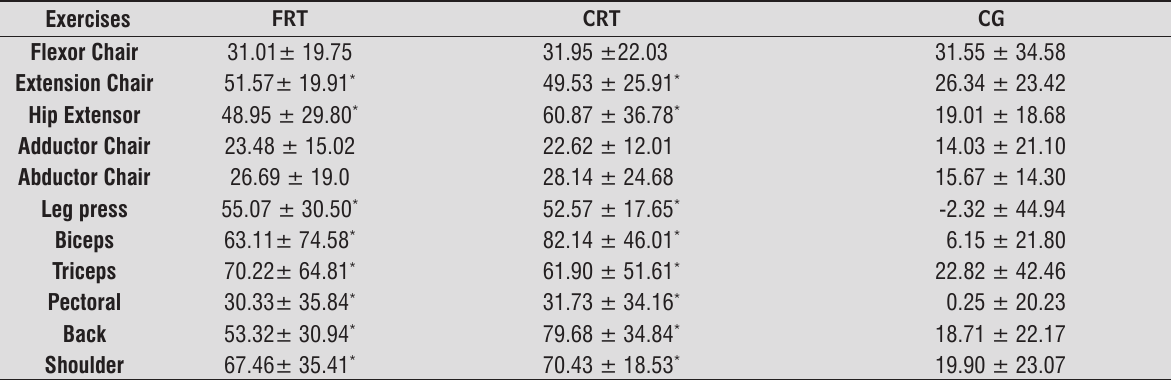
Table 4 - Percentage gain in the 1RM test of the exercises for the upper and lower limbs